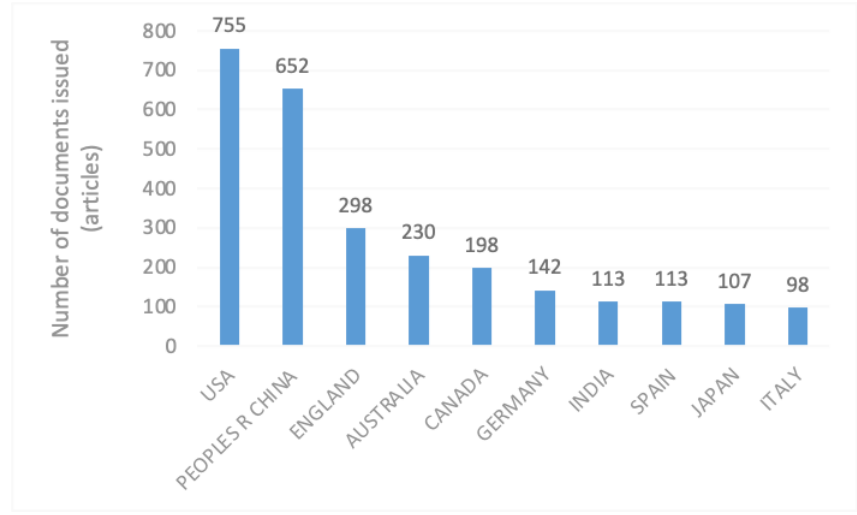
Figure 12. National distribution statistics of rural human settlement environment research.